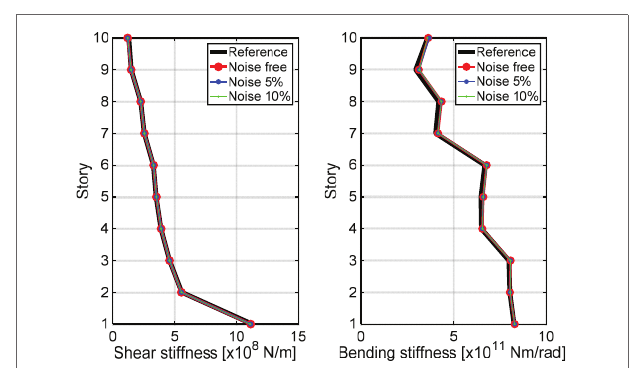
FIGURE 8 | Identified shear and bending stiffnesses in simultaneous measurement